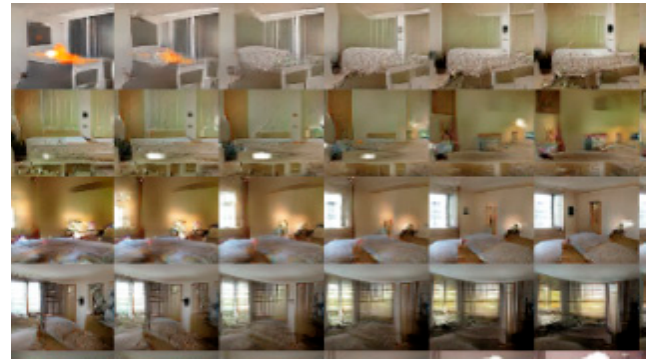
Figure 40. Reconstructed bedroom images using deep convolution GAN (DCGAN).